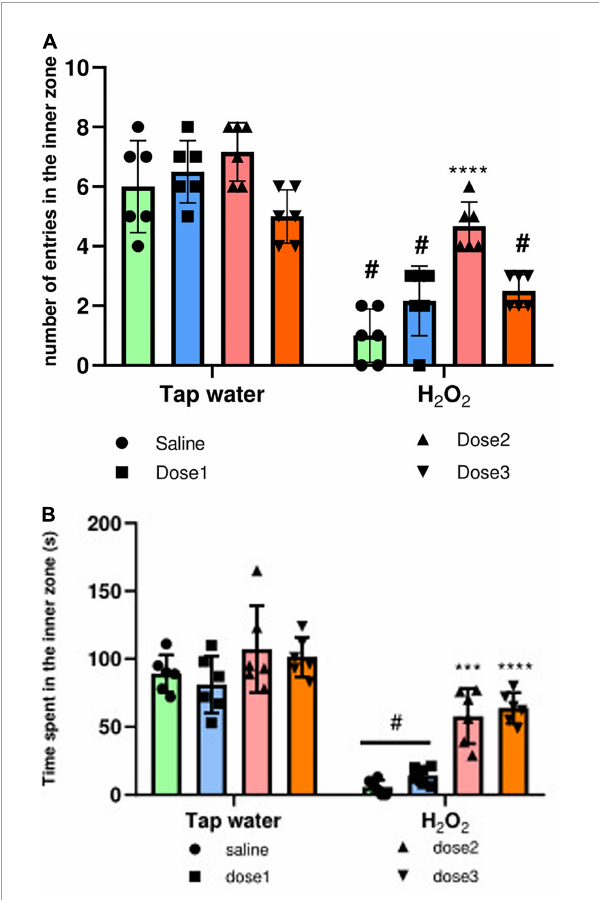
FIGURE5 Effect of the interaction between the extract treatment and the exposure to H 2 O 2 on Anxiety-like symptoms assessed by the OF test. (A) The number of entries in the inner zone of the OF. (B) The time spent in the inner zone. The results were presented as mean ± SD ( n = 6). Data were analyzed by Two-ways ANOVA followed by Bonferroni’s post-hoc test; *** p ≤ 0.001, **** p ≤ 0.0001 compared to saline group in the same treatment conditions. (#) in comparison with the control group (group 1).